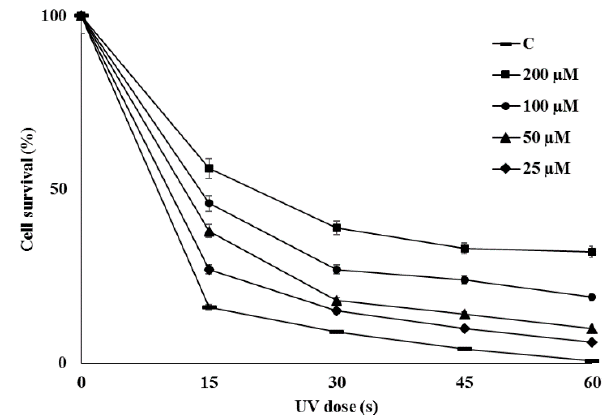
Figure 6. Effect of different concentration of compound IBR-3 on survival rates of UV-irradiated Escherichia coli BL21 (DE3).